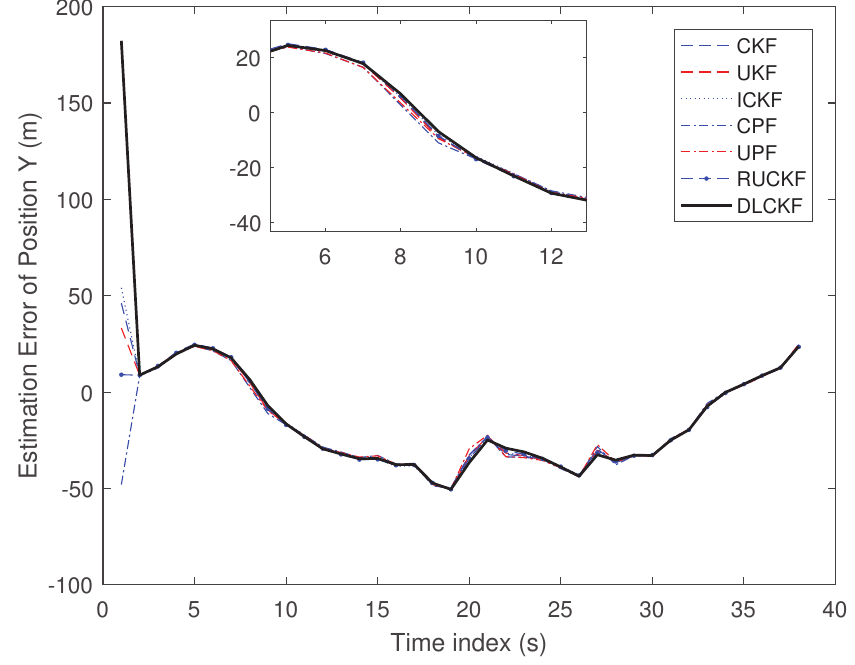
Figure 6. Estimation Error of Position Y (m).